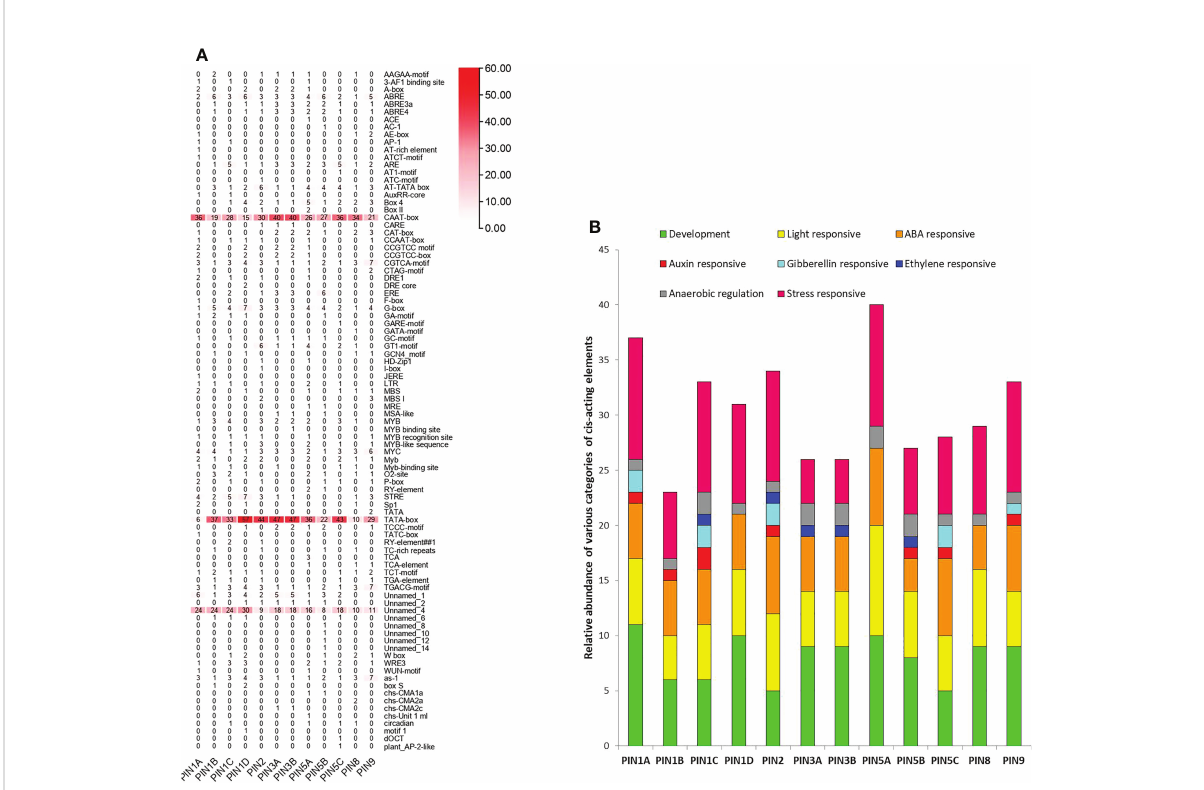
FIGURE 4 The cis -acting regulatory elements present in the 2-kb upstream putative promoter region of rice PIN genes. (A) Total number of different cis - acting regulatory elements in the respective PIN gene promoters. (B) The total number of cis -elements was classi fi ed into eight categories and their relative abundance in the respective